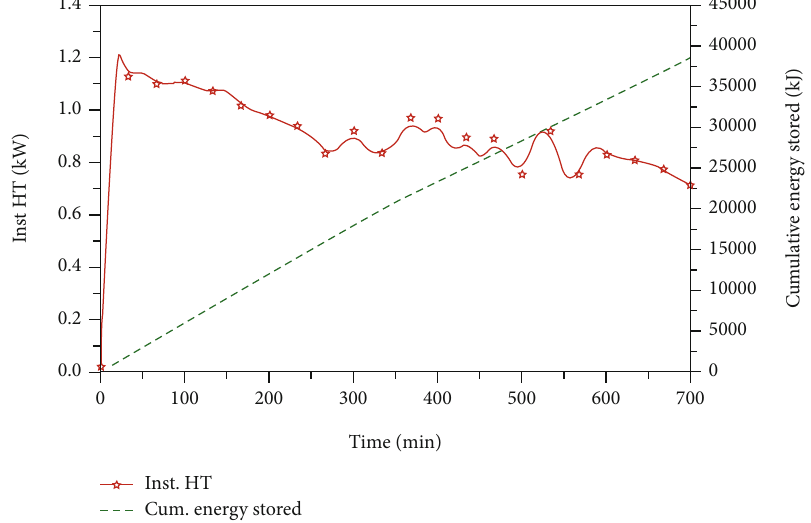
Inst. HT Cum. energy Figure 5: Instantaneous heat transfer and cumulative energy stored in the storage tank for a mass fl ow rate of 400